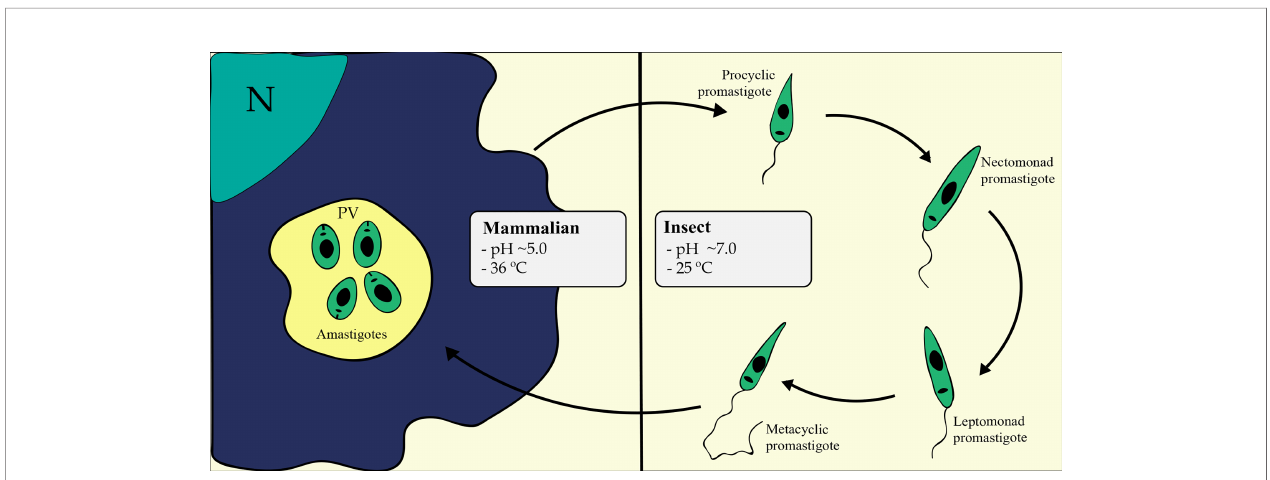
FIGURE 1 | Leishmania life cycle in mammalian and insect hosts. The differentiation processes involve drastic changes in pH, temperature, and nutrient availability, challenging the parasite ’ s ability to orchestrate its gene expression accordingly. Metacyclogenesis is essentially represented in the right portion of the fi gure, comprising the differentiation from procyclic into nectomonad and then into leptomonad and metacyclic forms inside the sand fl y digestive tract. Amastigogenesis is represented in the left portion of the fi gure, comprising the differentiation from metacyclic promastigote to amastigote forms inside the mammalian host macrophage. N, Macrophage Nucleus; PV, Parasitophorous